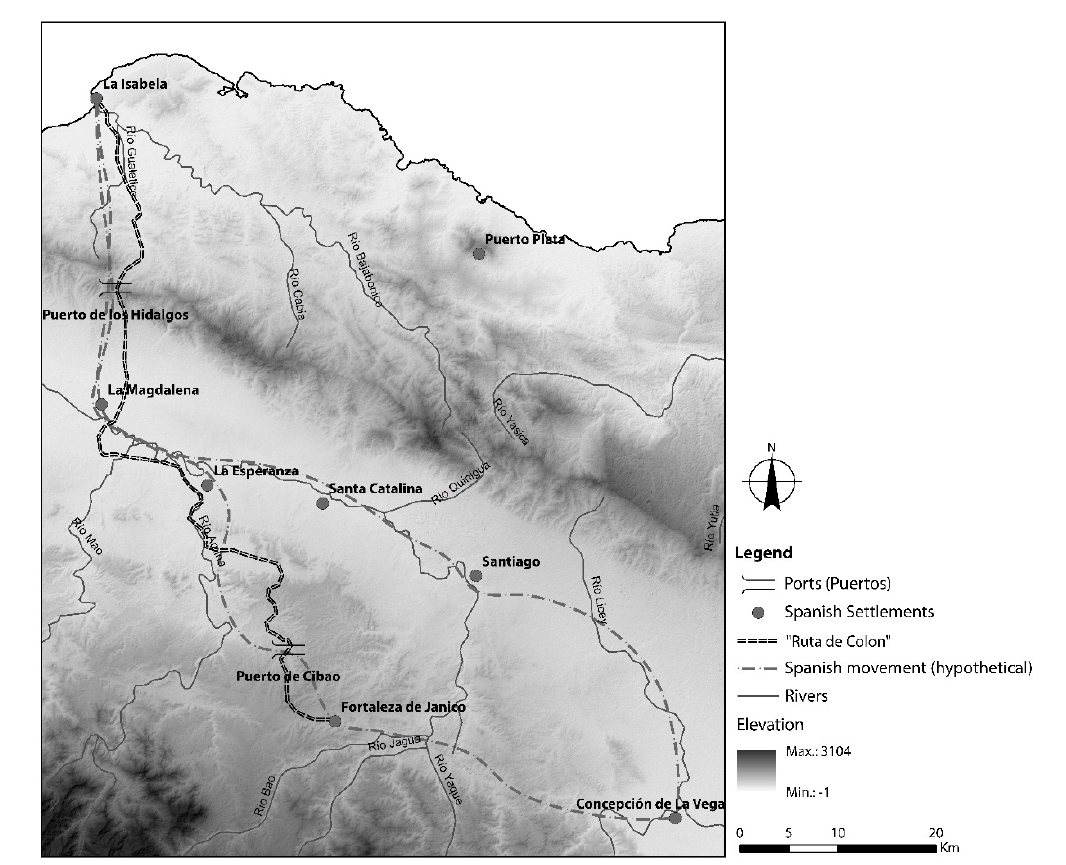
Figure 6. Spanish settlements and movements in the north of Haytí during the first years of colonization (approximate locations based on Sauer [47]).